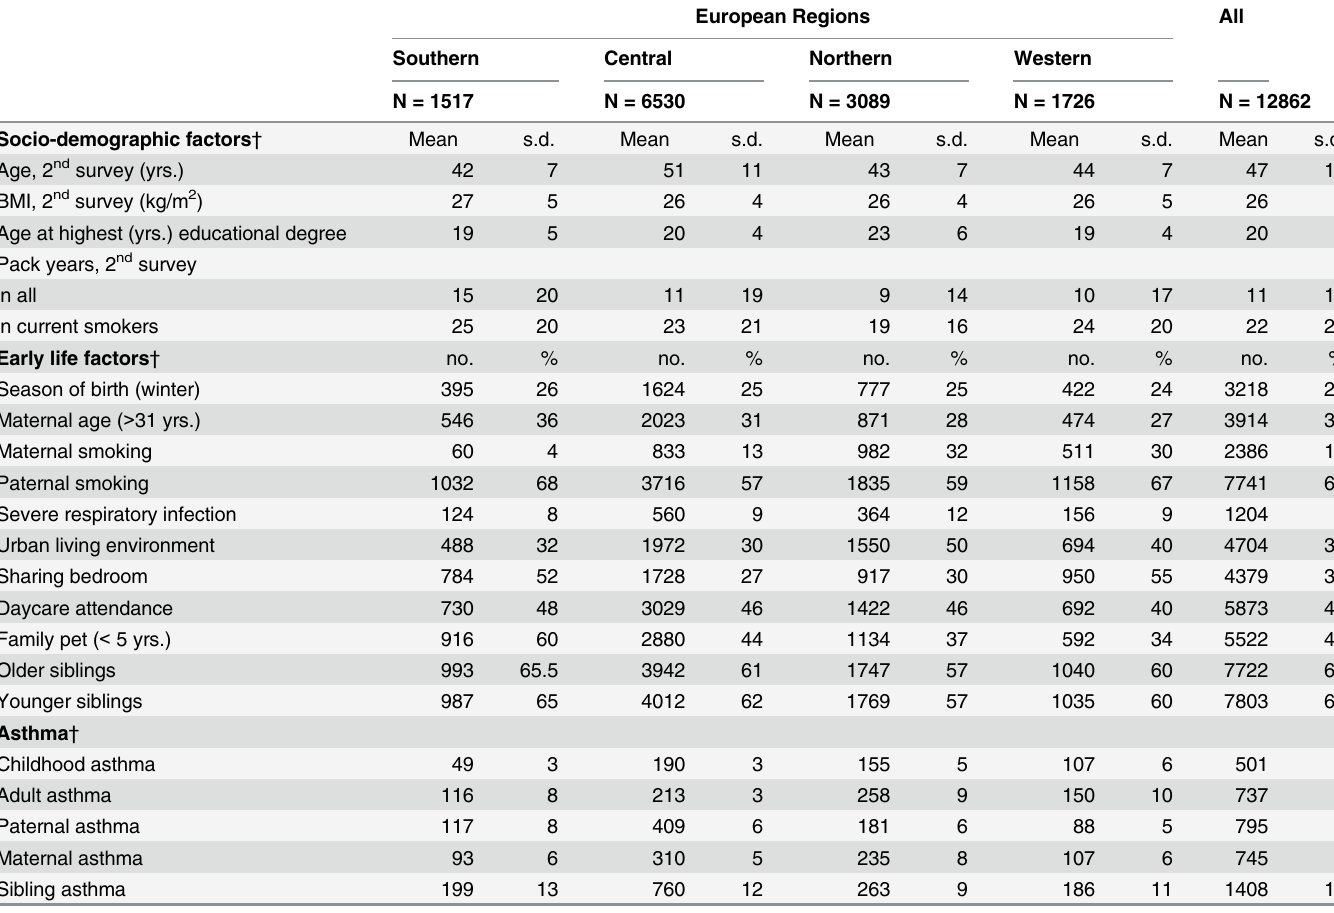
Table 1. Characteristics of the study population of the ECRHS and SAPALDIA cohorts, by European region.